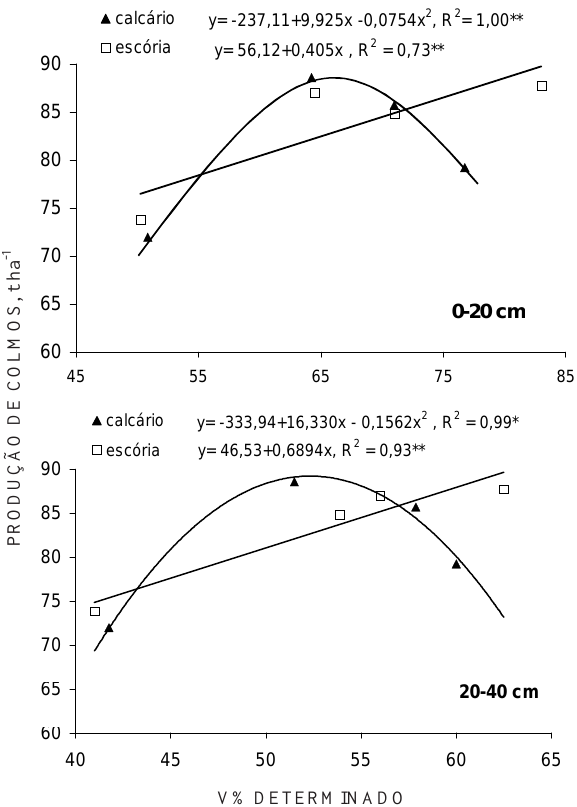
Figura 5. Relação entre a produção de colmos da cana-de-açúcar e a saturação por bases corrigida pela aplicação do calcário e da escória de siderurgia nas profundidades de 0- 20 e 20-40 cm. (Dados médios de duas épocas de amostragens e quatro